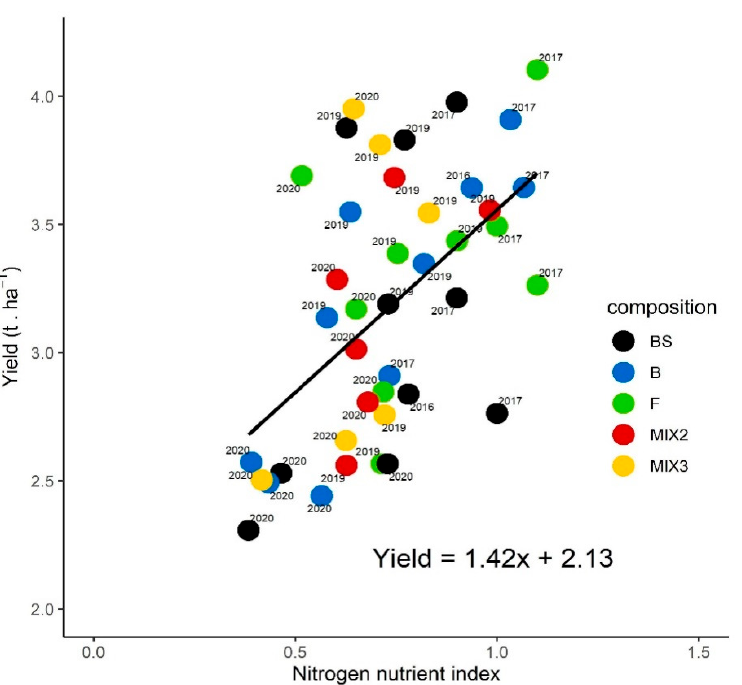
Figure 7. The causal relationship between manual sunflower yield (t ha − 1 ) and nitrogen nutrition index at sunflower flowering cultivated after bare soil (BS), Brassicaceae (B) sole crops, Fabaceae (F) sole crops, a mixture with one Brassicaceae and one Fabaceae (MIX2), and a mixture with two Brassicaceae and one Fabaceae (MIX3) in 2016, 2017, 2019 and 2020. Each point represents the mean values of the yield and the NNI of the composition of each year and each block. In 2019, the turnip rape did not grow in the mixture with fodder radish and purple vetch.